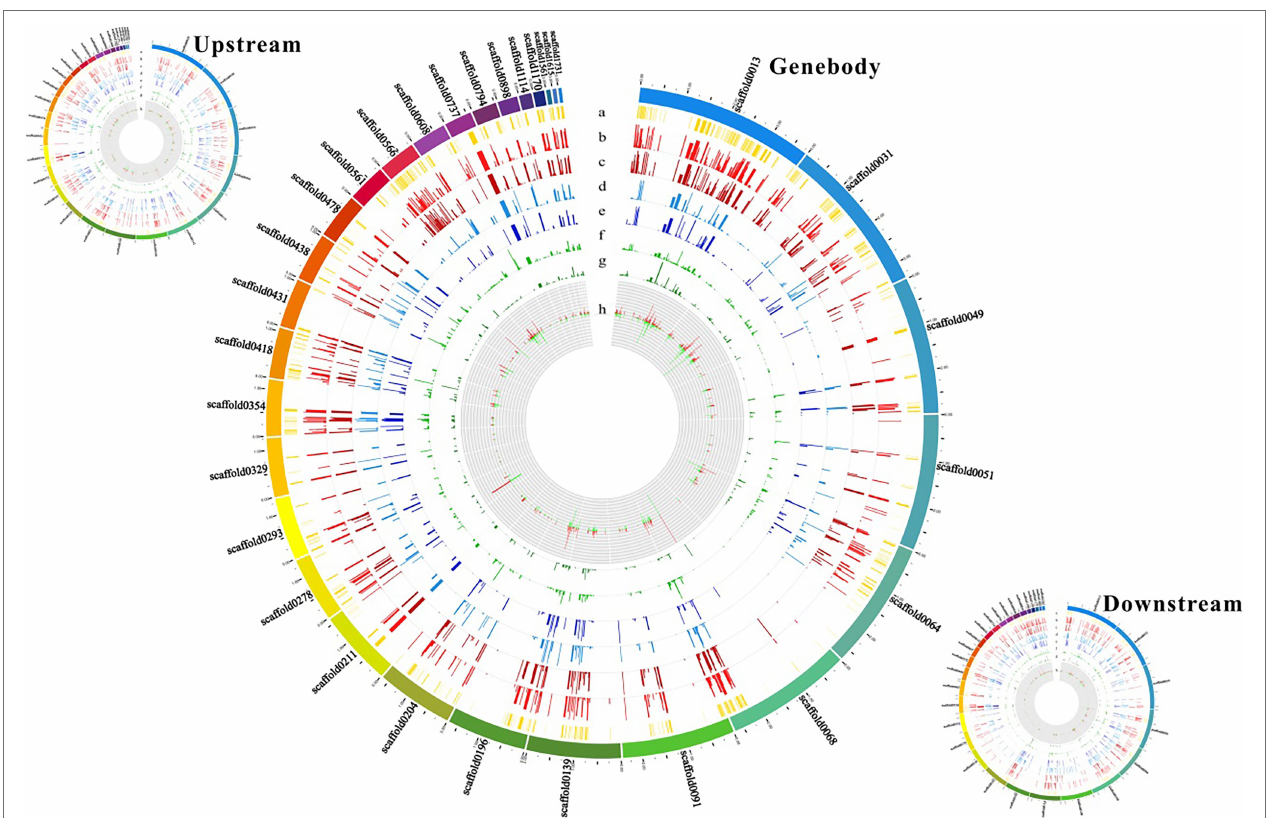
FIGURE 5 | Circos plot showing methylation sites and gene expression levels at the genomic level. Outer rings represent different scaffolds. (a) Yellow column represents the base site where the methylation takes place. (b) Red column represents the mCG methylation site in the control sample. (c) Dark red column represents the mCG methylation site in the cold-treated sample. (d) Blue column represents the mCHG methylation site in the control sample. (e) Dark blue column represents the mCHG methylation site in the cold-treated sample. (f) Green column represents the mCHH methylation site in the control sample. (g) Dark green column represents the mCHH methylation site in the cold-treated sample. (h) Up- and down – regulation of gene expression levels after cold treatment indicated by red and green colors,